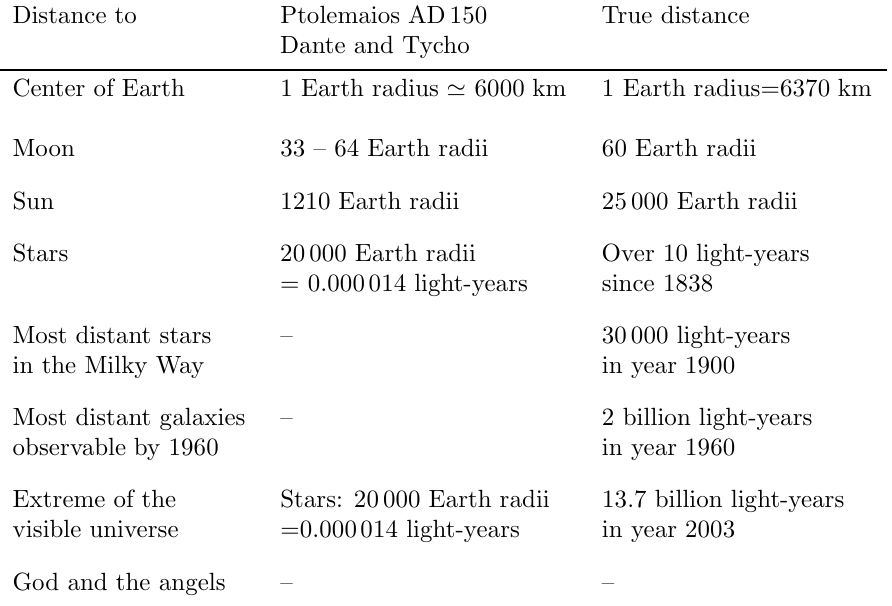
Table 1. Historical and contemporary distances – the visible universe is a million billion times larger than Tycho Brahe believed. Distance to Ptolemaios AD 150 True distance Dante and Tycho Center of